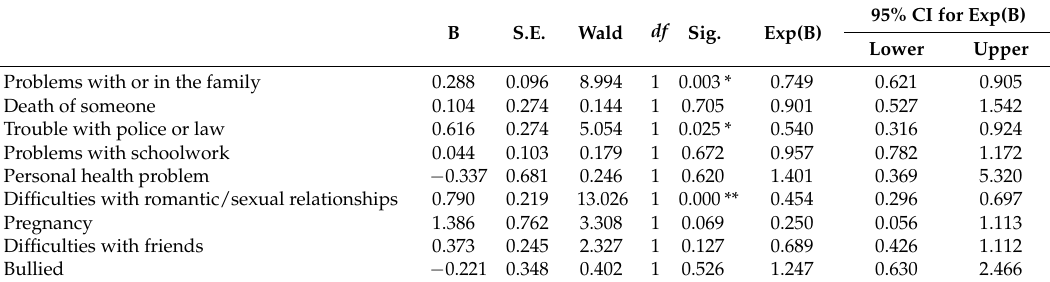
Table 4. D-SIB and life event categories in high school